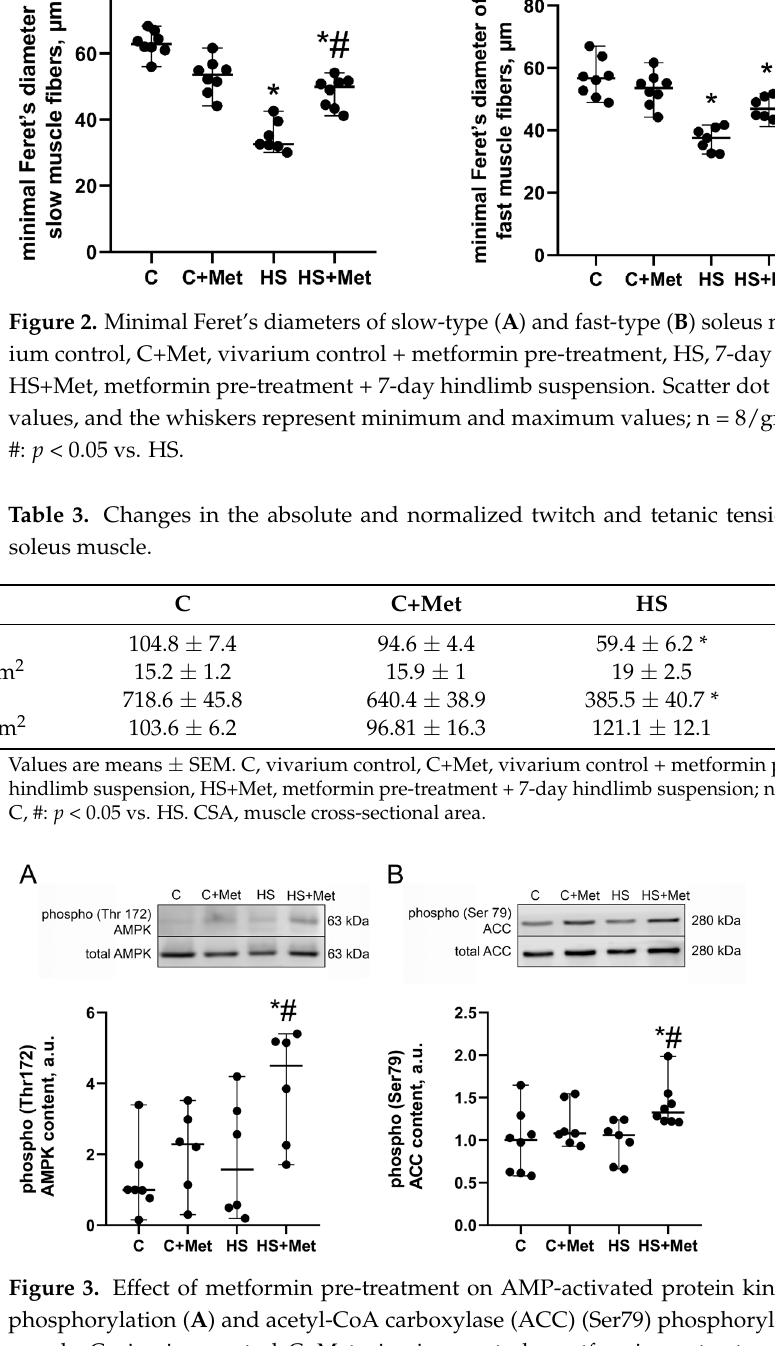
Figure 1. Cross-sectional area (CSA) of slow-type ( A ) and fast-type ( B ) fi bers and the number of slow-type ( C ) and fast-type ( D ) fi bers in rat soleus muscle. C, vivarium control, C+Met, vivarium control + metformin pre-treatment, HS, 7-day hindlimb suspension, HS+Met, metformin pre-treat- median values, and the whiskers represent minimum and maximum values; n = 8/group. *: p < 0.05 ment + 7- day hindlimb suspension. Scatter dot plots indicate median values , and the whiskers rep- vs. C, #: p < 0.05 vs. HS. resent minimum and maximum values; n = 7–8/group. *: p < 0.05 vs. C, #: p < 0.05 vs. HS.